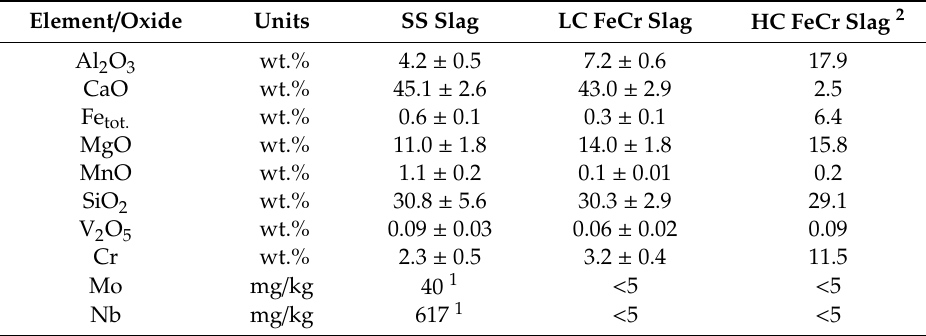
Table 3. Chemical composition of the studied